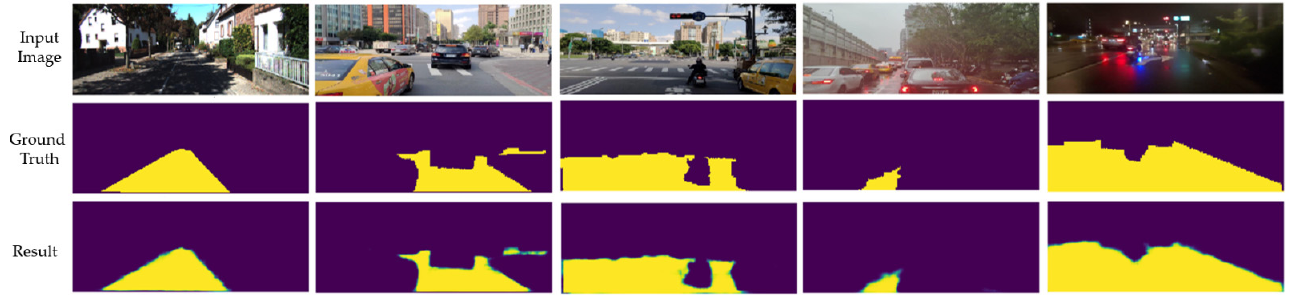
Figure 12. Road semantic segmentation results using LWF-VGG FCN.